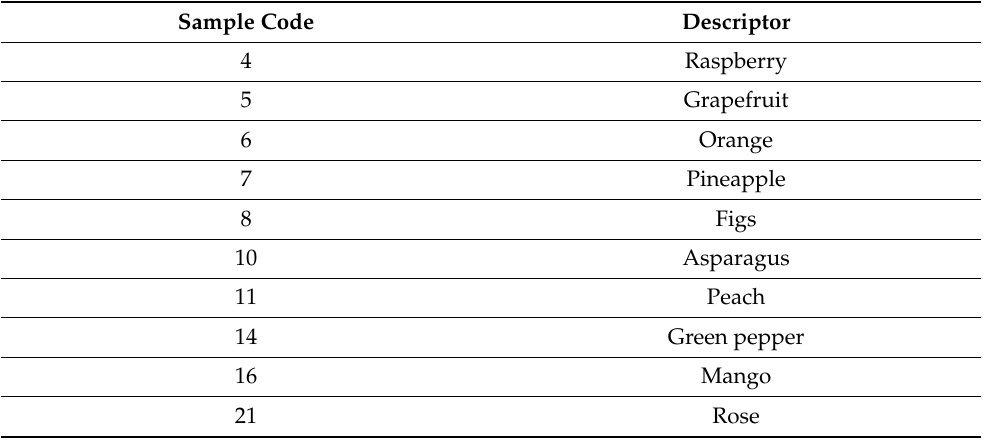
Table 2. Odorants selected for the testing